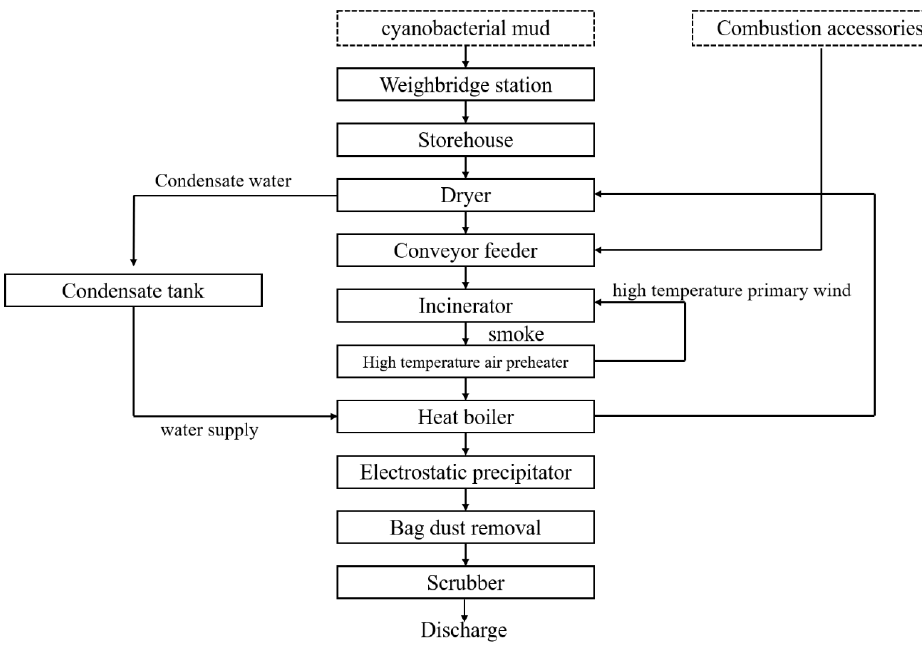
Figure 5. Process flowchart of cyanobacteria drying and incineration.